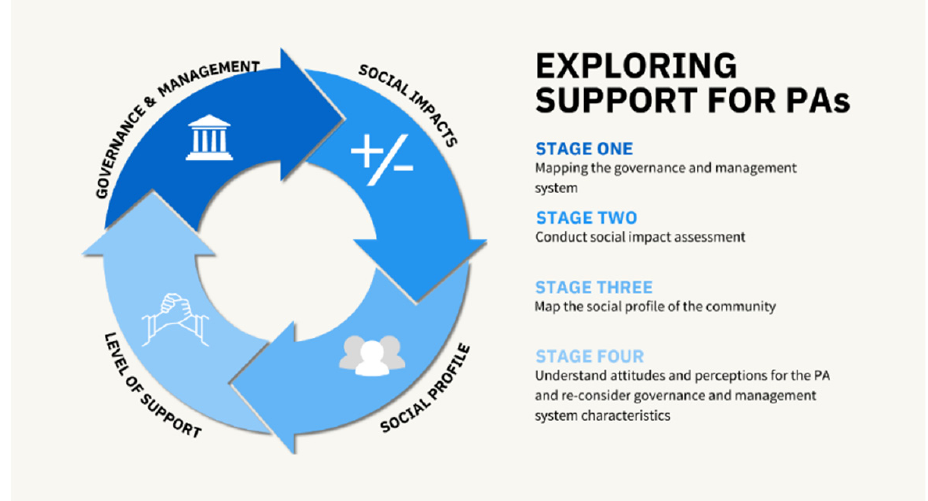
Figure 2. A stage-by-stage approach to explore public support for protected areas. Box 1. A stage-by-stage approach to explore public support for protected